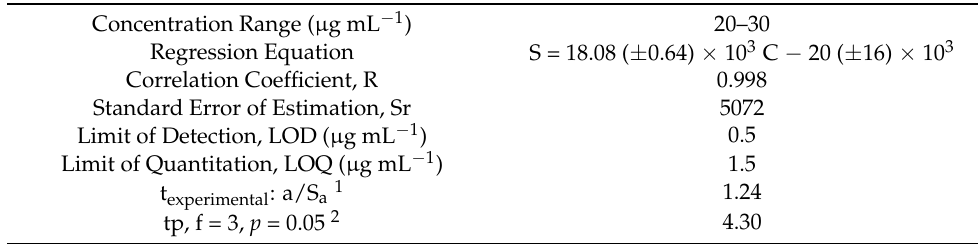
Table 1. Linearity data for the quantitation of acetyl hexapeptide-8 in Argireline peptide solution C ® (formulation) as assessed by the HILIC-PDA method.